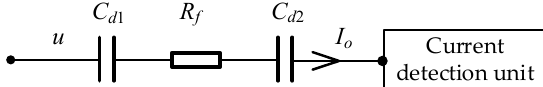
Figure 6. Basic structure of the logging instrument.